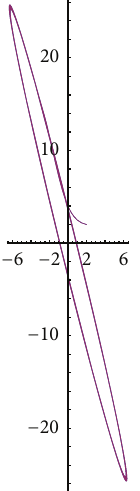
Figure 1: The equilibrium (0,0) of system (3) is stable with 𝜏 = 0.8 < = 0.935 . 𝜏 0